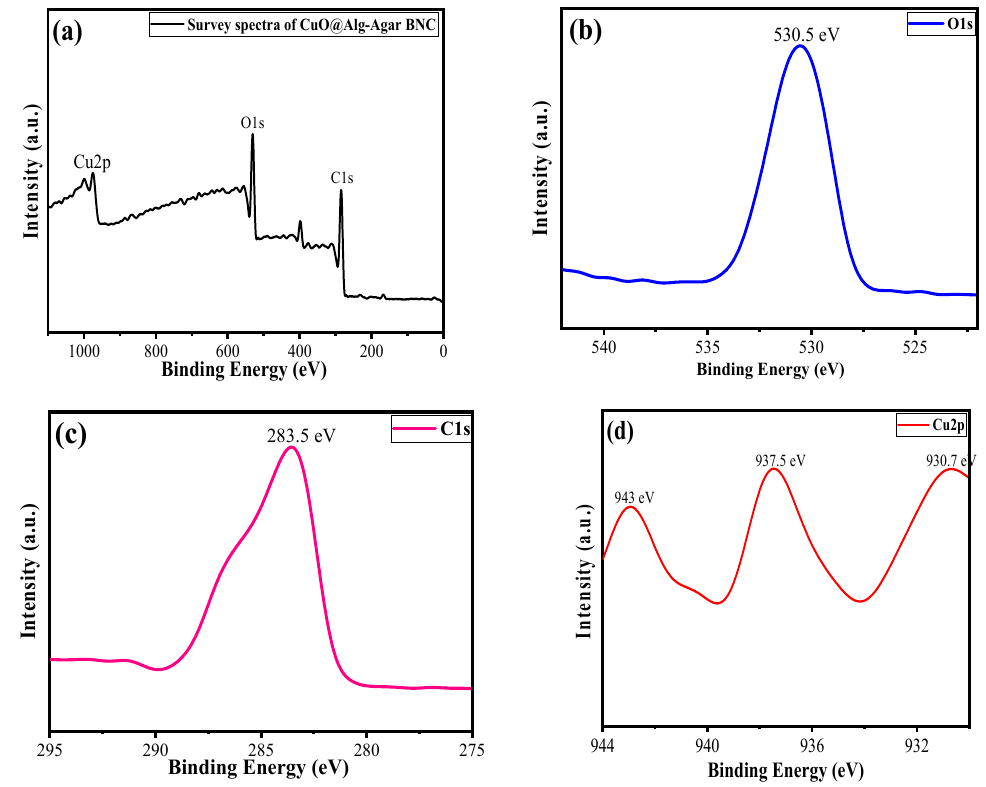
Figure 7. XPS spectra of ( a ) survey scan of CuO/Alg-Agar BNC, ( b ) O1s, ( c ) C1s and ( d ) Cu2p.